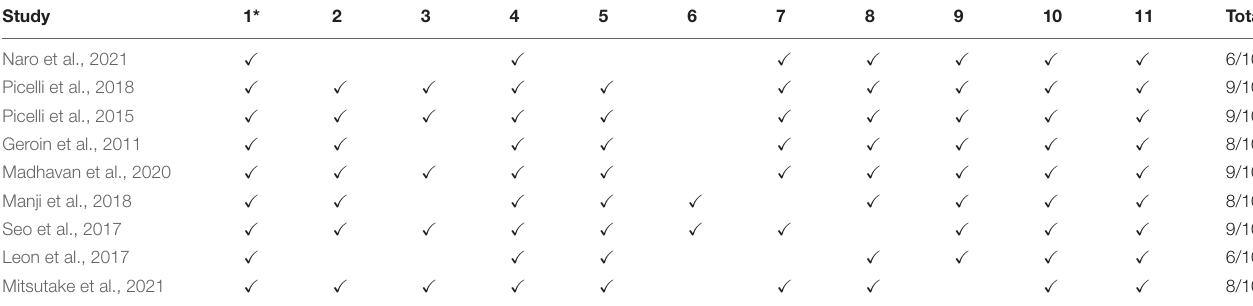
*Not included in the total score. PEDro scores: 1, eligibility criteria specified; 2, participants randomly allocated to groups; 3, allocation concealed; 4, groups similar at baseline; 5, participants were blinded; 6, therapists were blinded; 7, assessors were blinded; 8, data available for more than 85% of participants; 9, participants received the treatment as allocated or intention-to-treat analysis was used; 10, statistical analyses were reported; 11, point measures and variability measures of data reported. anodal tDCS in comparison to sham tDCS. The pooled effect estimate favored anodal tDCS in online stimulation: anodal tDCS ( n = 36) significantly increased the walking speed compared to sham tDCS ( n = 37) (SMD: 0.48; 95% CI: 0.01–0.94; p = 0.04; I 2 = 0%, Figure 2A ). In the offline stimulation, the effect of anodal tDCS ( n = 32) was not significantly different from that of sham tDCS ( n = 30) (SMD: 0.08; 95% CI: − 0.41, 0.58; p = 0.74; I 2 = 0%, Figure 2A ). After combining data from both online and offline stimulations, anodal tDCS ( n = 68) did not significantly increase the walking speed compared to sham tDCS ( n = 67) (SMD: 0.29; 95% CI: − 0.05, 0.64; p = 0.09; I 2 = 0%).